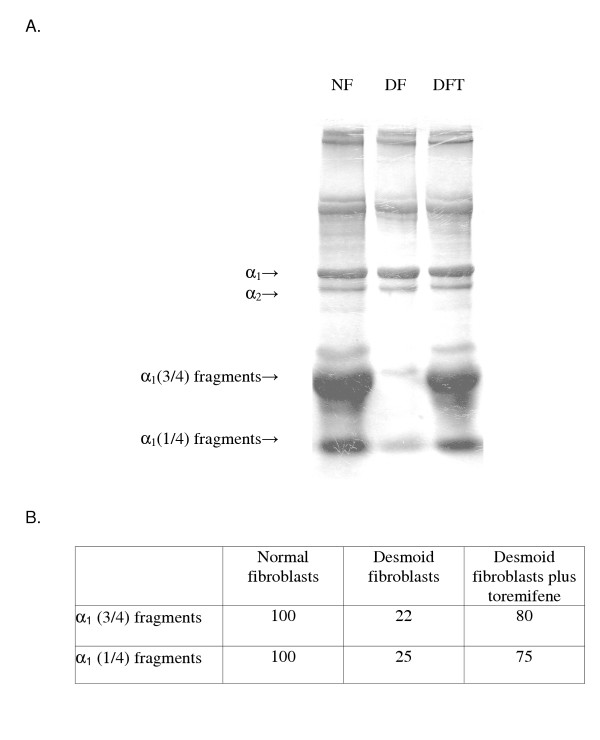
Collagenase activity in media derived from normal, desmoid fibroblasts and desmoid fibroblasts plus toremifene. Panel A. NF: normal fibroblasts; DF: desmoid fibroblasts; DFT: desmoid fibroblasts plus toremifene. Similar results were obtained in four separate experiments. In panel B the quantity of 3/4 and 1/4 fragments of digested collagen was determined by densitometric analysis. The absolute counts were converted to percentages assuming the level of normal fibroblasts as 100%.